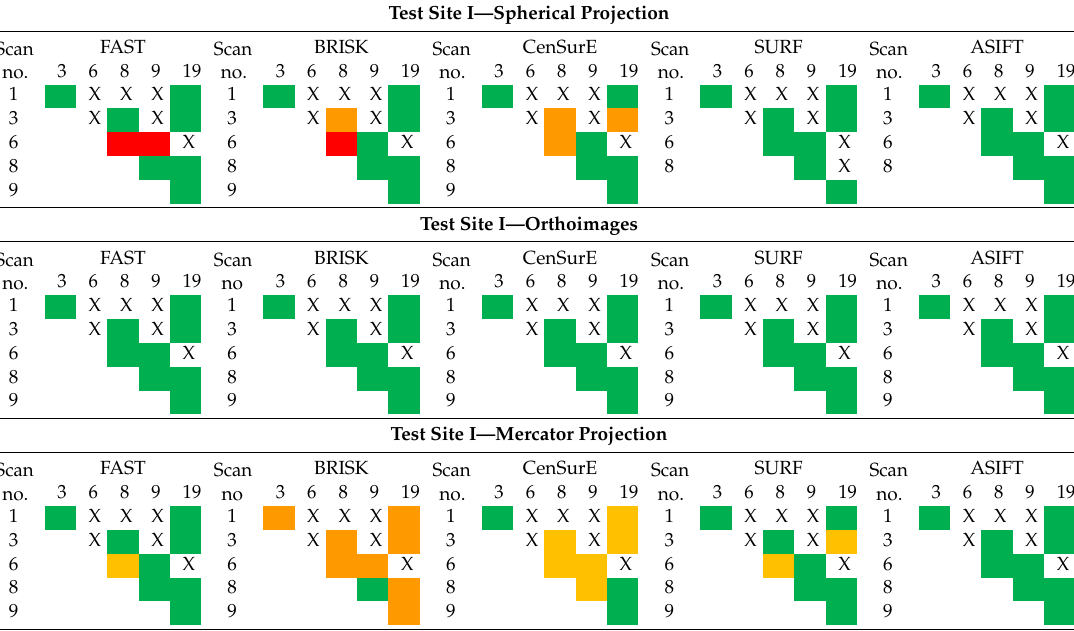
Test Site I—Mercator Projection